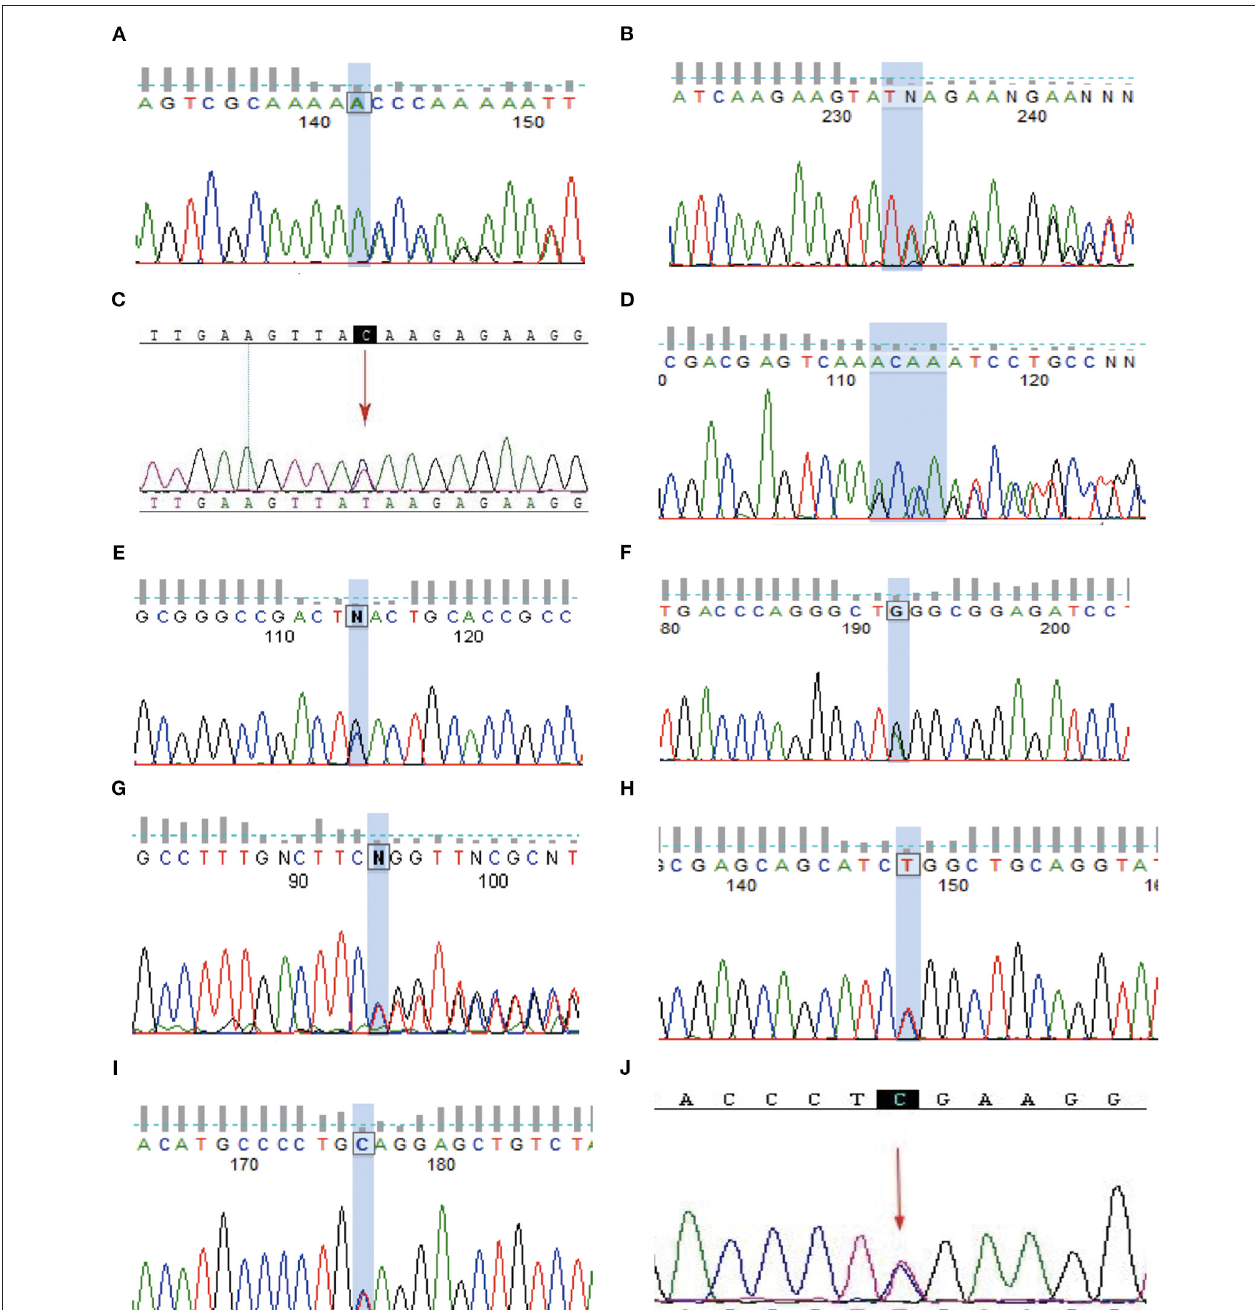
FIGURE 3 | Sanger validation. (A–J) Represents genetic mutation in the (A–J) family, respectively.